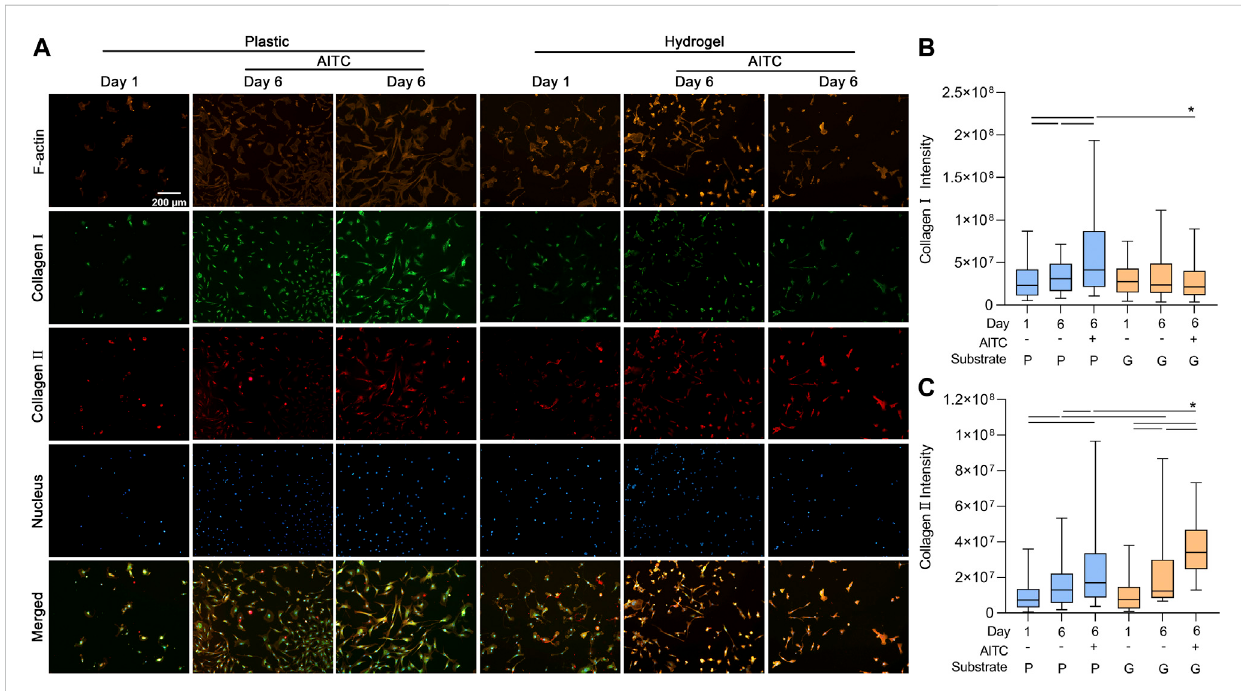
FIGURE 4 TRPA1activation promotedcollagen Ⅰ and Ⅱ synthesis. CHsweredividedintotwogroups:onewascultured onplasticandtheotherwasculturedon hydrogel.Eachgroupwasthensub-groupedintothree:1-dayculture,6-dayculture,and6-dayculturewithAITCtreatment. (A) Representativeimagesof F-actin,collagen Ⅰ / Ⅱ ,andnucleusstainingofCHs,andthequantitativeanalysisof (B) collagen Ⅰ intensityand (C) collagen Ⅱ intensity.Resultsareexpressed using the box plots ( n = 80 – 200 cells). Repeated measures ANOVA followed by Dunnett ’ s post-test was used in the statistical analysis. The differencesareconsideredstatisticallysigni fi cantat p < 0.05.(P:plastic,G:hydrogel;line:lineonthetopoftheboxespointstothecomparedobjectswith